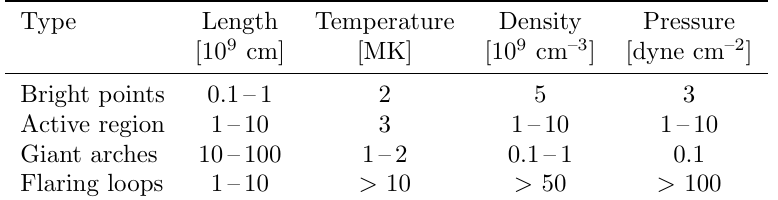
Table 1: Typical X-ray coronal loop